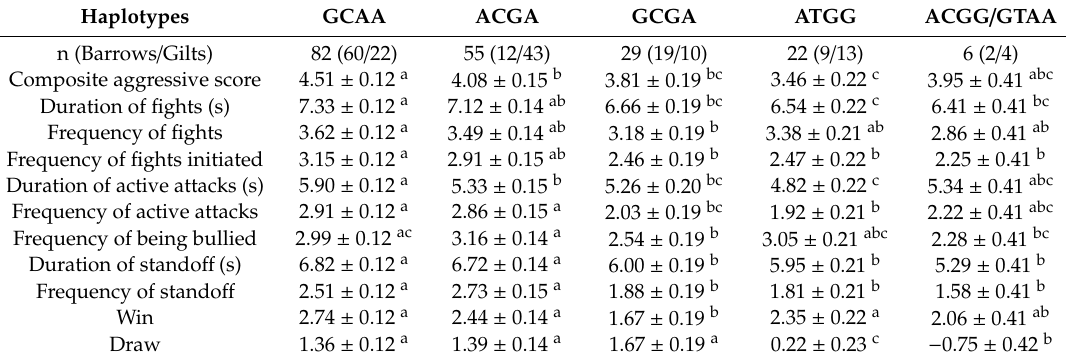
Table 4. Aggressive behavior indicators of pigs with different haplotypes of the four linked SNPs.